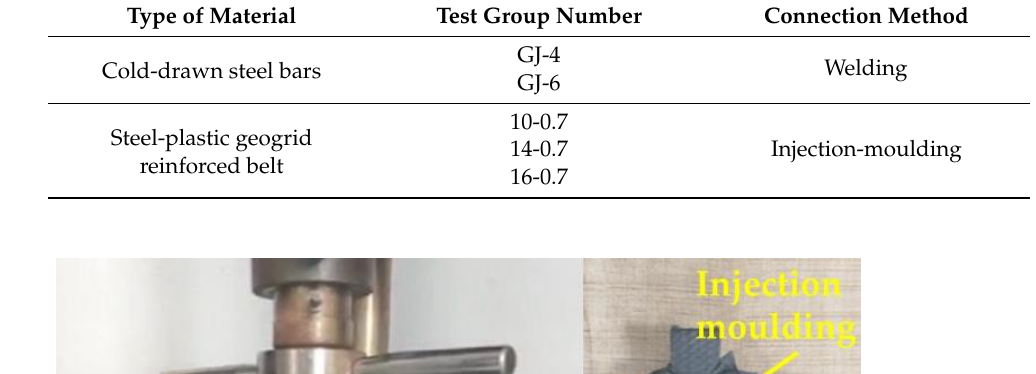
Table 2. Peel test group design.